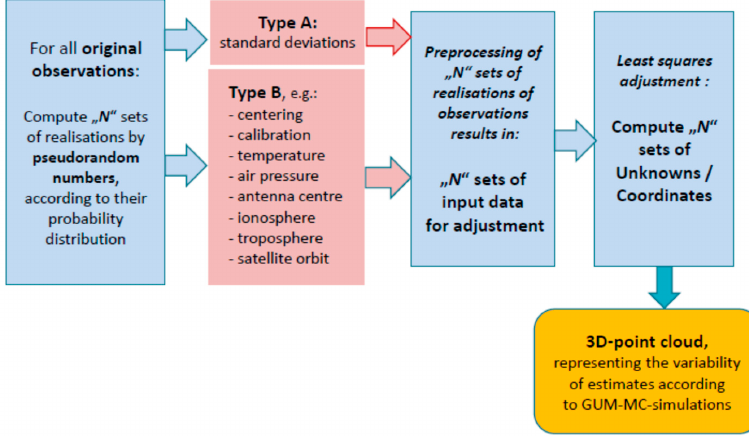
Figure 6. GUM concept for creation of “ 𝑁 ” sets of input data used in Monte Carlo (MC) simulations for least squares network adjustments.